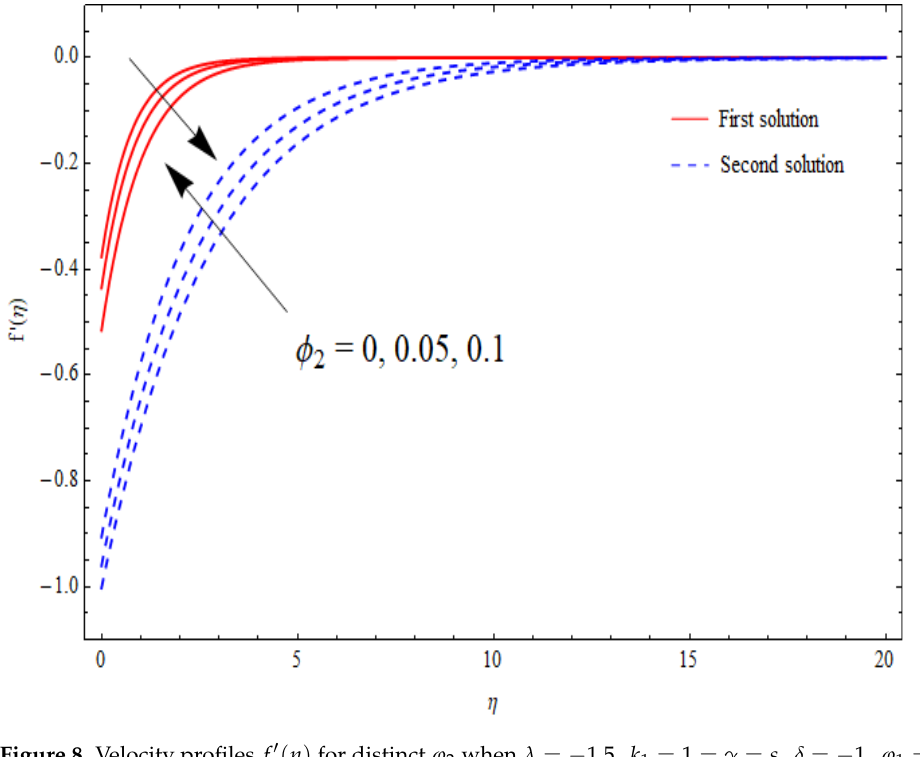
Figure 8. Velocity profiles f (cid:48) ( η ) for distinct ϕ 2 when λ = − 1.5, k 1 = 1 = γ = s , δ = − 1, ϕ 1 = 0.1.